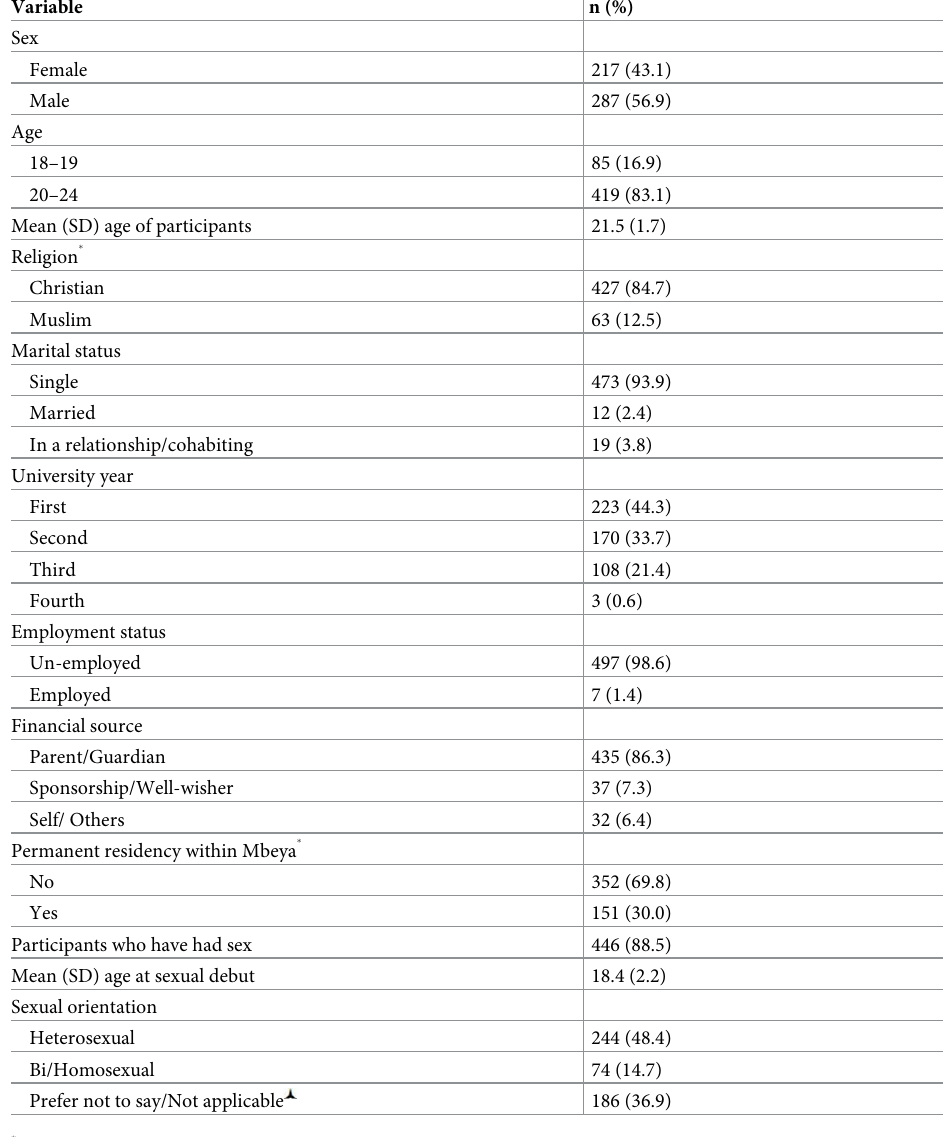
Table 1. Socio-demographic and sexual characteristics of the participants (N = 504).